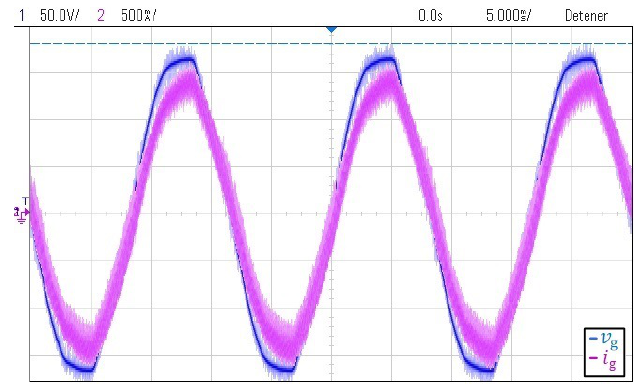
Figure 24. Waveforms of v g and i g for I s = 222mA.